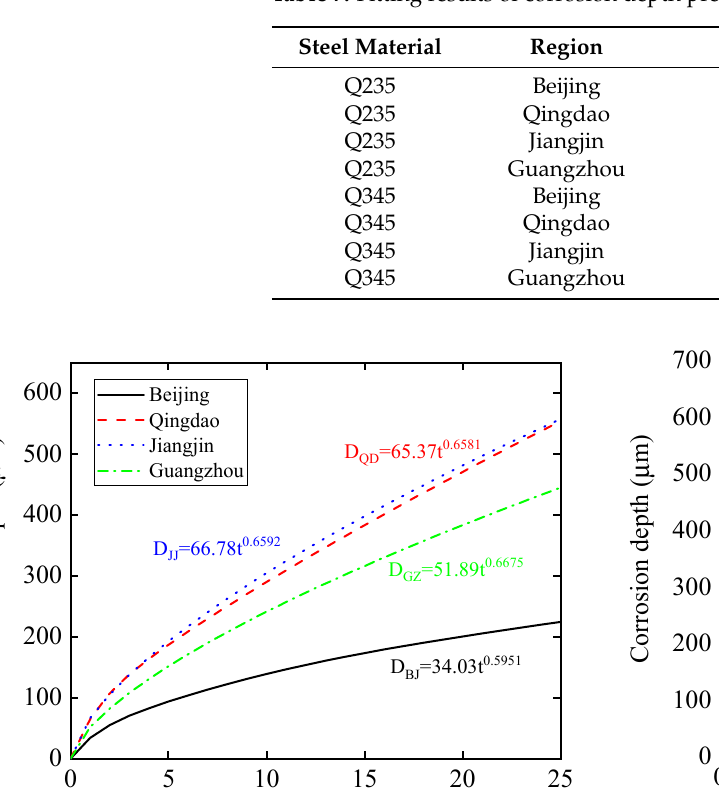
Table 7. Fitting results of corrosion depth prediction values.